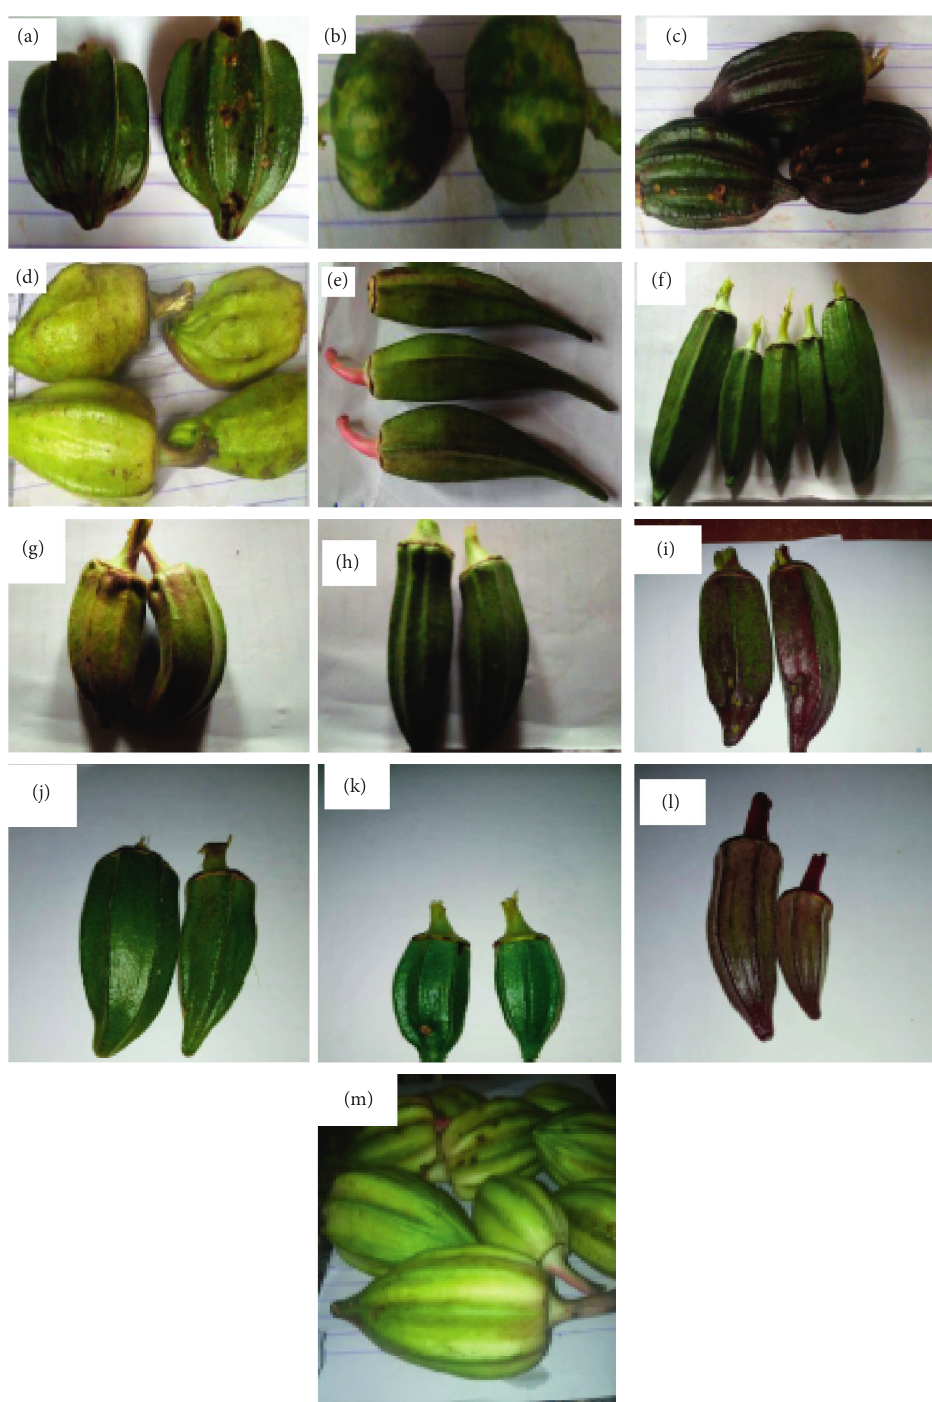
Figure 1: Variability in okra fruits: (a) NGB00386; (b) NGB00371; (c) NGB00486; (d) NGB00345; (e) NGB00470; (f) NGB00378A; (g) NGB00331; (h) NGB00356; (i) NGB00430; (j) NGB00299; (k) NGB00355; (l) NGB00304; (m)